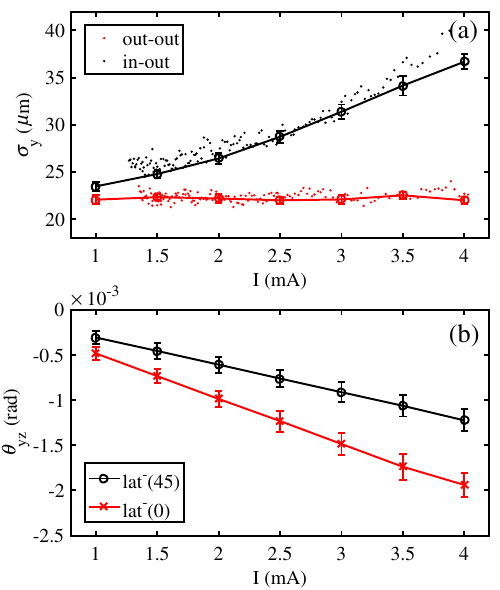
FIG. 7. (a) Measured vertical beam size σ y as a function of bunch current for lat − ð 45 Þ of electrons (circles: simulation). (b) Tilt angle θ yz from tracking simulations for lat − ð 0 Þ and lat − ð 45 Þ with top scraper inserted ( “ in-out ”